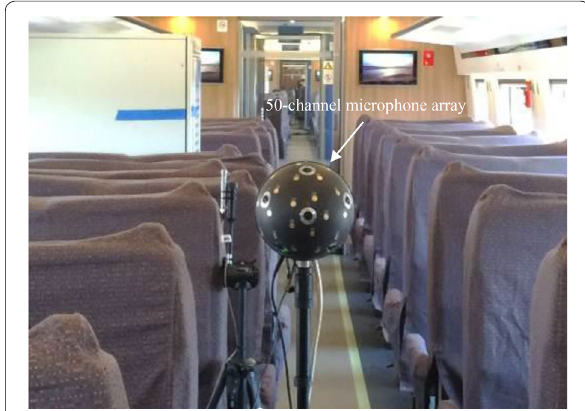
Figure 6 Measurement photograph of the interior noise source identification